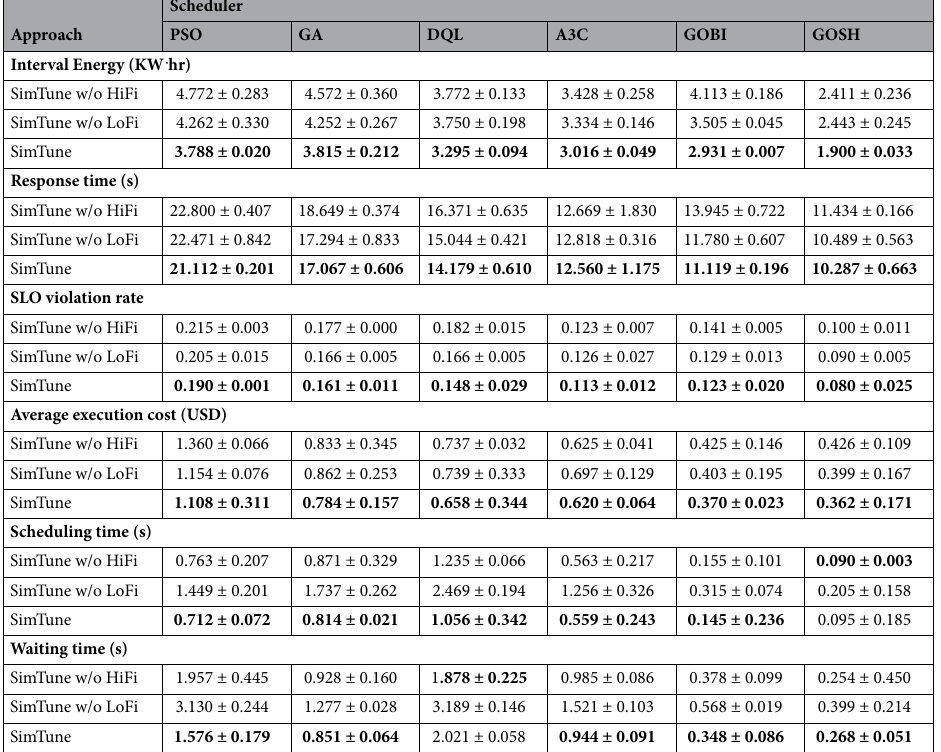
Table 1. Ablation analysis. Best values are shown in